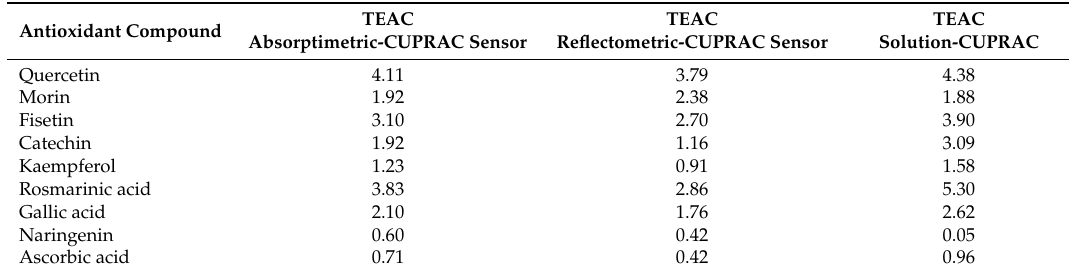
Table 1. The Trolox-equivalent antioxidant capacities (TEAC) of selected antioxidants using absorptimetric- and reflectometric-CUPRAC sensors and solution-based method. Antioxidant